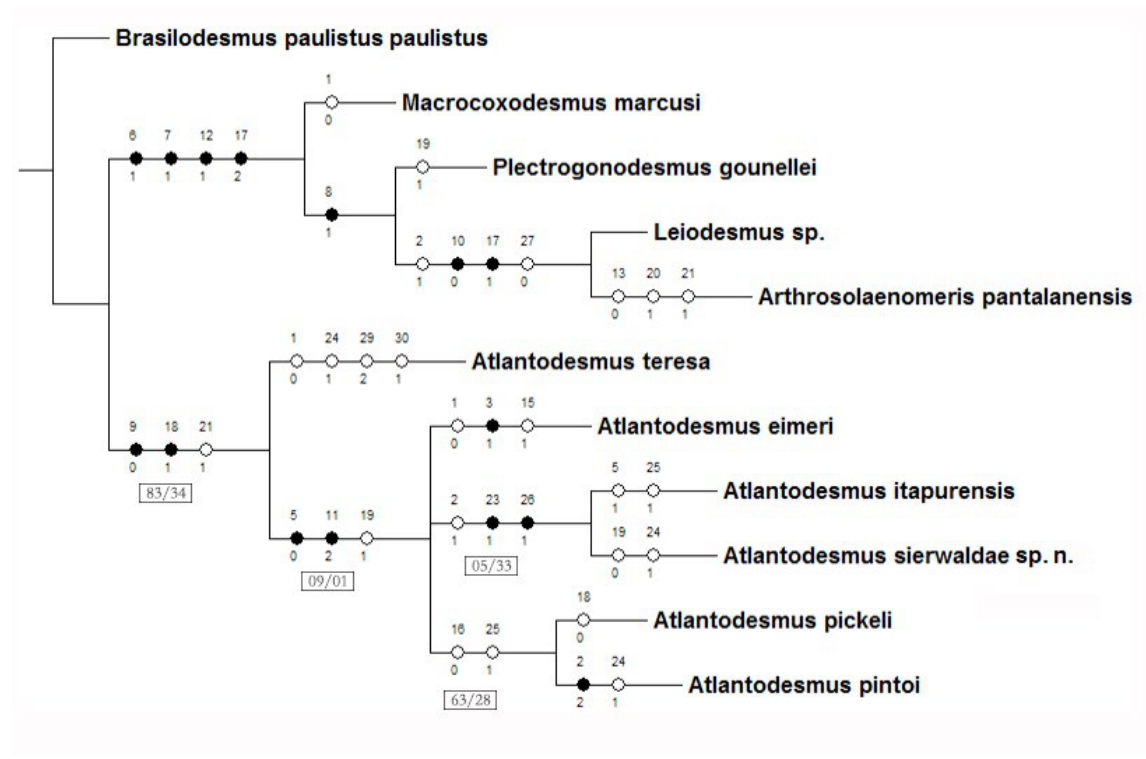
Fig. 1. Strict consensus of the two most parsimonious trees obtained with implied weighting of the characters (k = 3) (length = 58 steps; total fit = 23.150; CI = 0.64; RI = 0.64). Black circles correspond to unique transformations and white circles to homoplastic transformations. Values below branches refer to the GC values (Symmetric Resampling) and relative Bremer support. Only unambiguous changes are shown in this